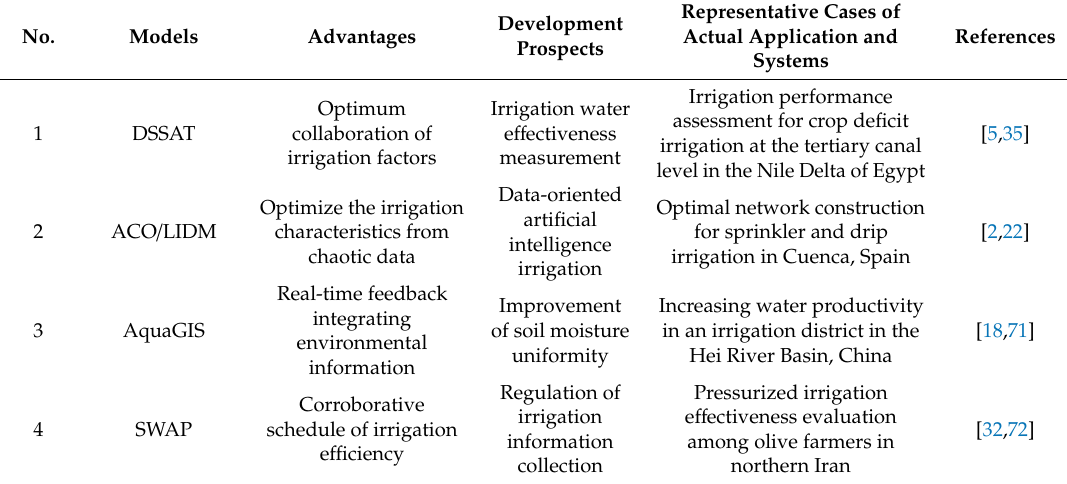
Table 3. The advantages and development prospects of representative irrigation